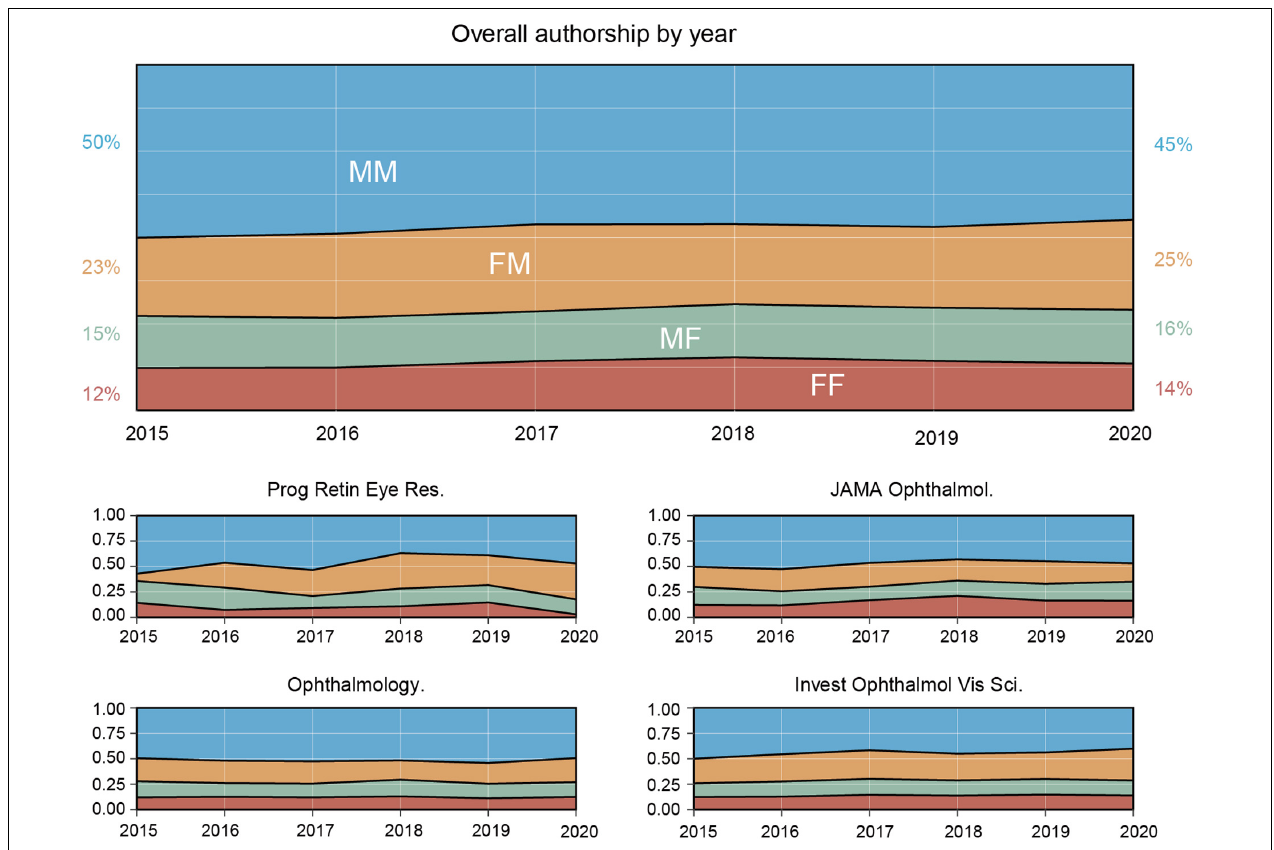
FIGURE 1 | Trends of gender among authors within the four ophthalmology journals between August 2015 and July 2020. Proportions of published papers with male as first and last authors (MM, blue), female as the first author and male as the last author (FM, yellow), male as the first author and female as the last author (MF, green), and female as the first and last authors (FF, red) are plotted as a function of time (between August 2015 and July 2020) in four ophthalmology journals: Prog Retin Eye Res , Ophthalmology , JAMA Ophthalmol, and Invest Ophthalmol Vis Sci . The overall trend of these four journals is also plotted (top